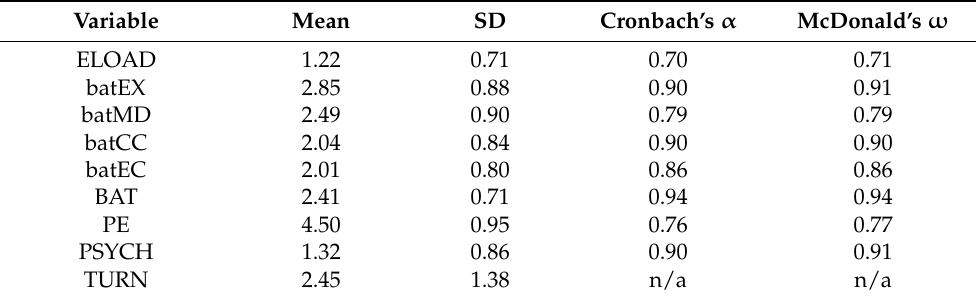
Table 1. Descriptive statistics and reliability coefficients for the study.